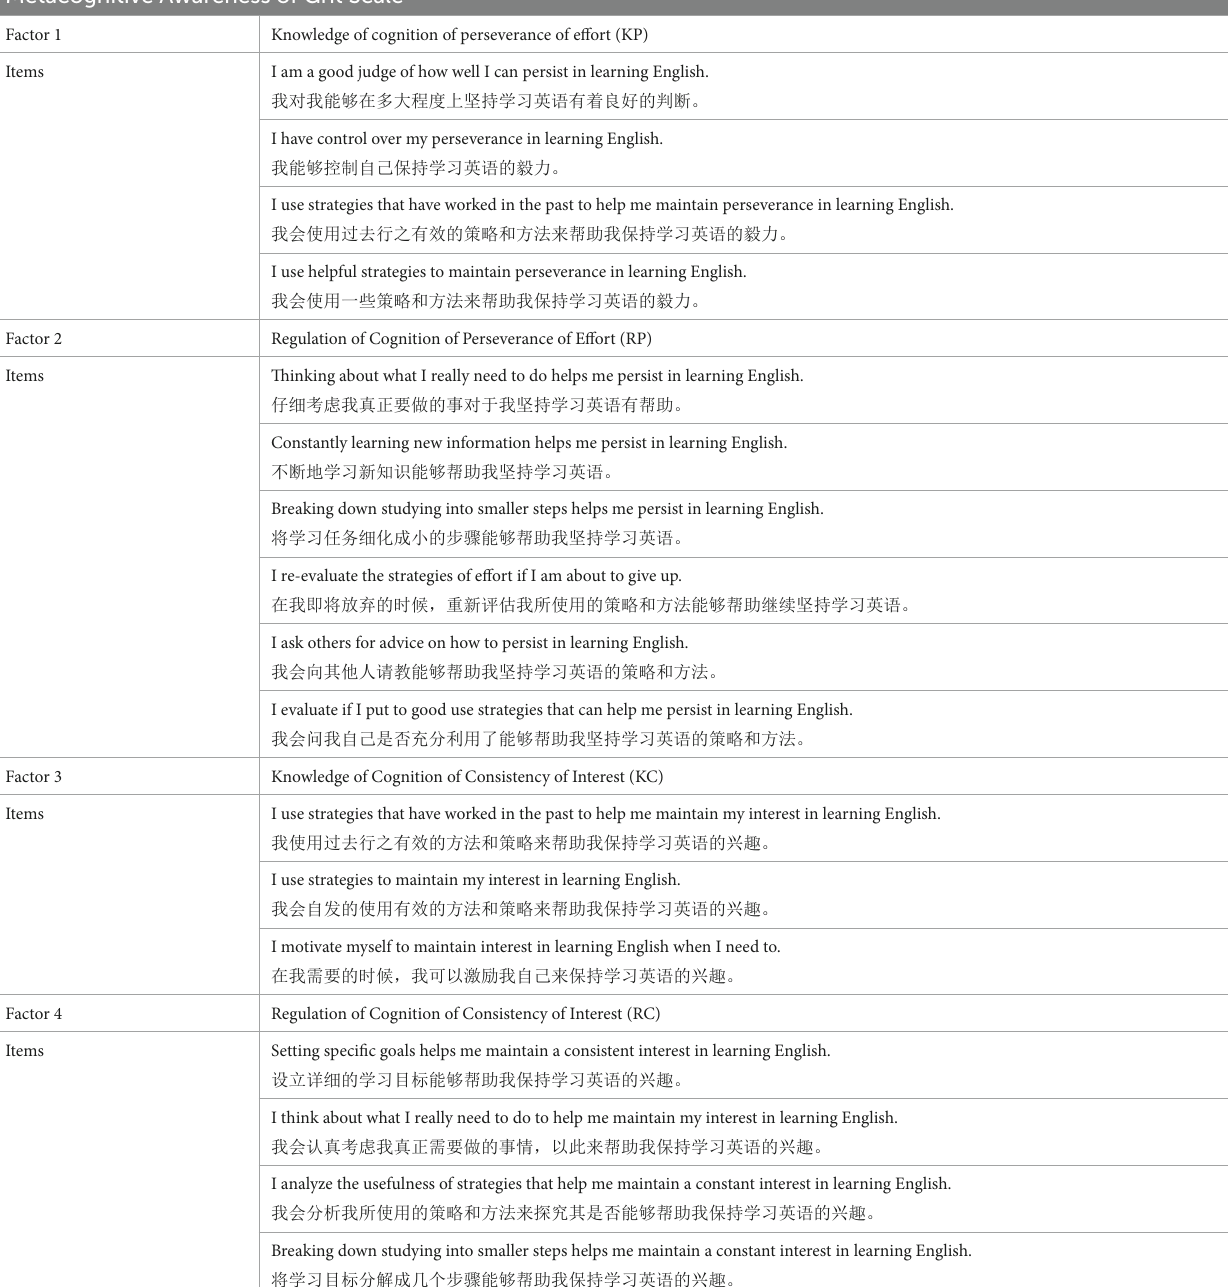
TABLE 6 Seventeen-item MCAGS. Metacognitive Awareness of Grit